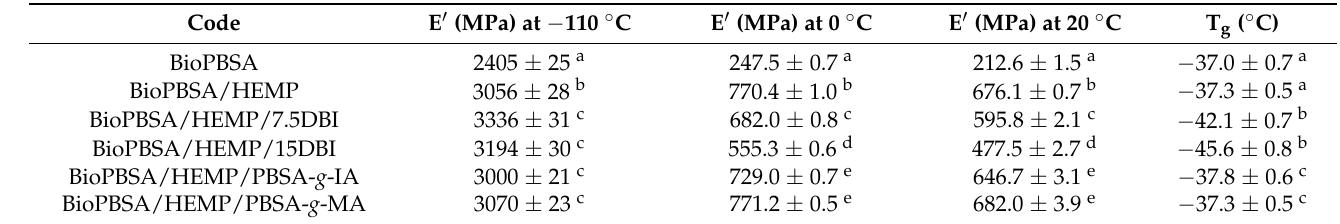
Figure 5. Plot evolution of ( a ) the storage modulus (E ′ ) and ( b ) the dynamic damping factor (tan δ ) of the injection-molded samples of BioPBSA/HEMP composites. Table 5. Dynamic-mechanical properties of injection-molded samples of BioPBSA/HEMP composites, at different temperatures.